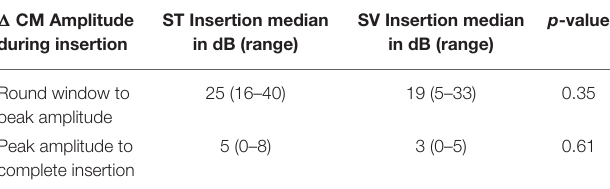
TABLE 4 | Various objective measures of change in cochlear microphonic (CM) amplitude during insertion are compared between scala tympani (ST) and scala vestibuli (SV)